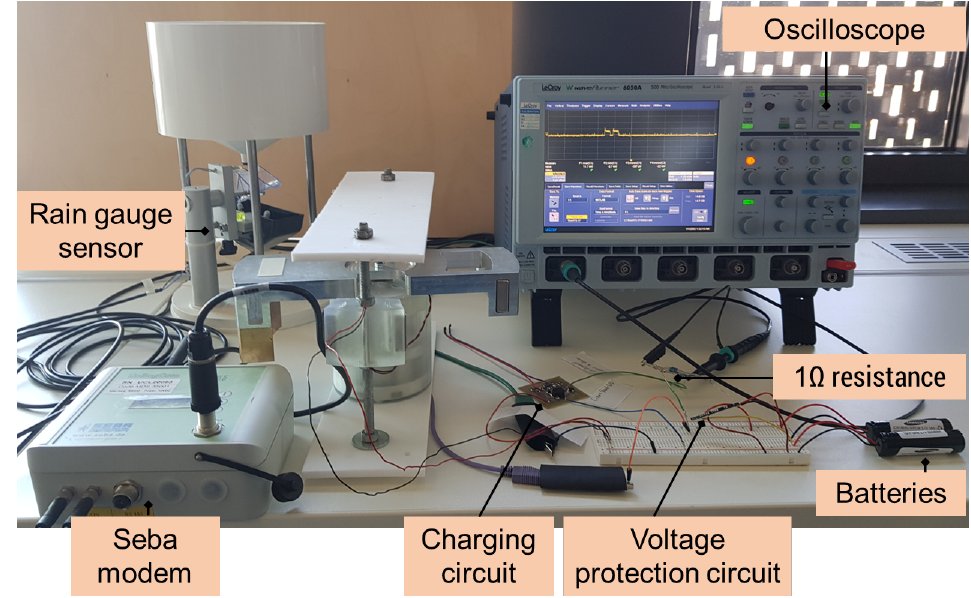
Figure 11. Experimental setup for laboratory characterization of the energy management and storage circuits.